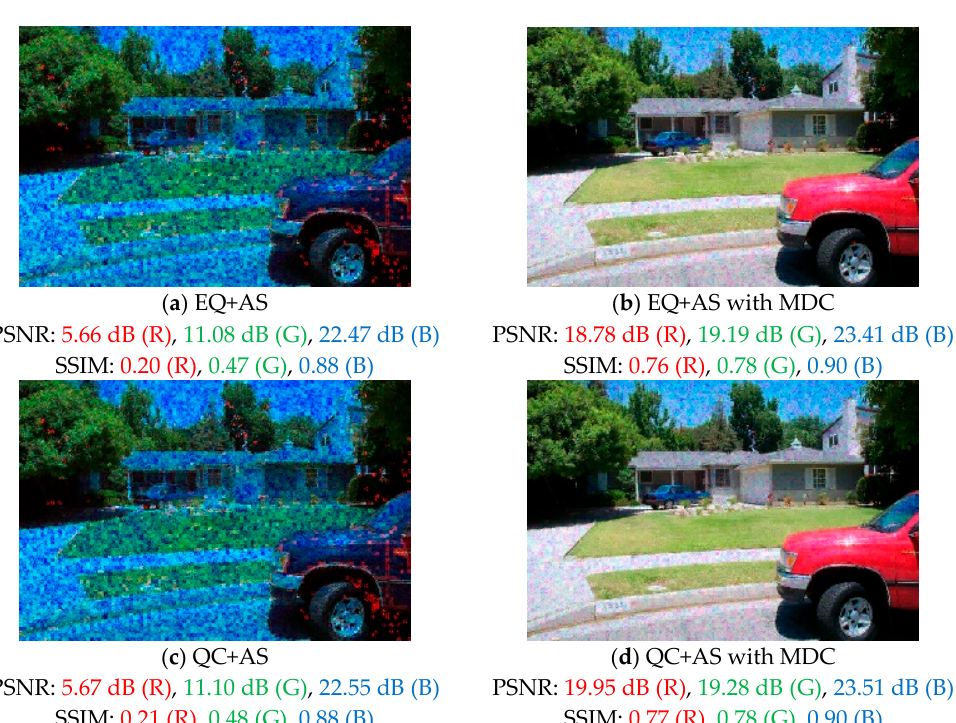
Figure 14. Demonstration of lossy transmission in the red and green planes: ( a ) EQ + AS; ( b ) EQ + AS with MDC; ( c ) QC + AS; and ( d ) QC + AS with MDC.